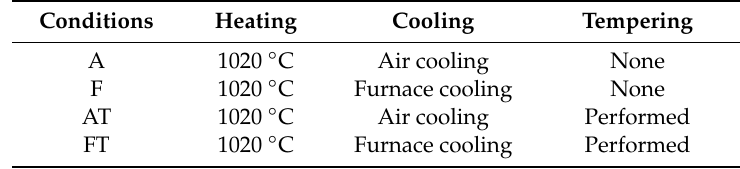
Table 3. Post-heat treatment conditions.